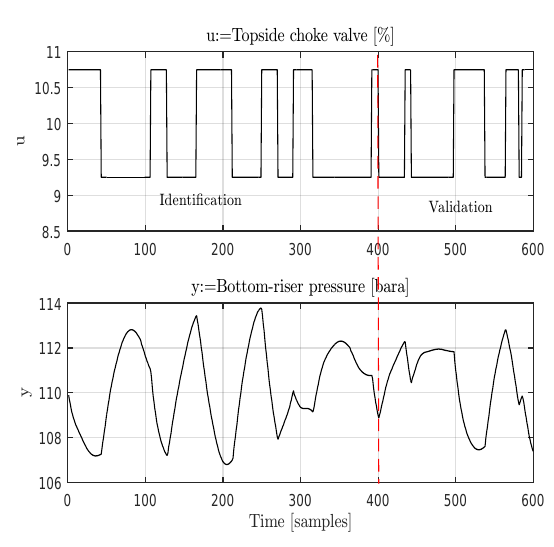
Figure 7: Example 4.3. The figure shows the open loop PRBS input experiment of the well-pipeline- riser example in the K-Spice/LedaFlow simulator.